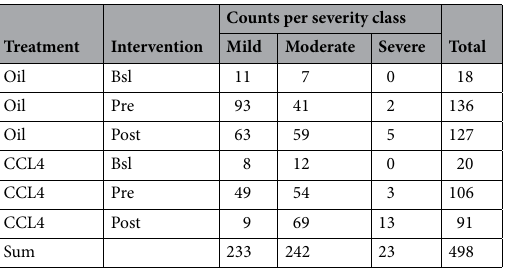
Table 3. Severity class distribution in the treatment and intervention groups.